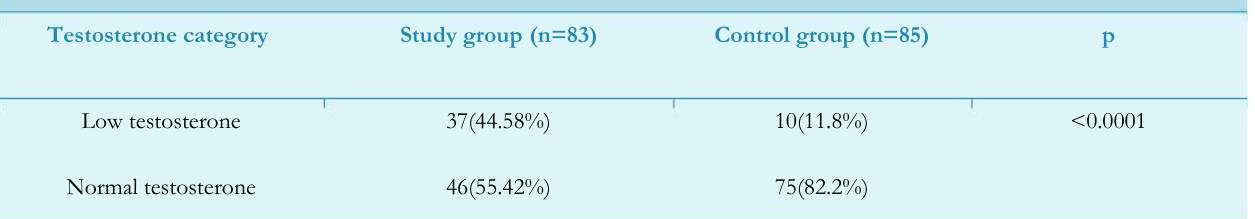
Table 3: Serum testosterone in the study group and the control group Testosterone category